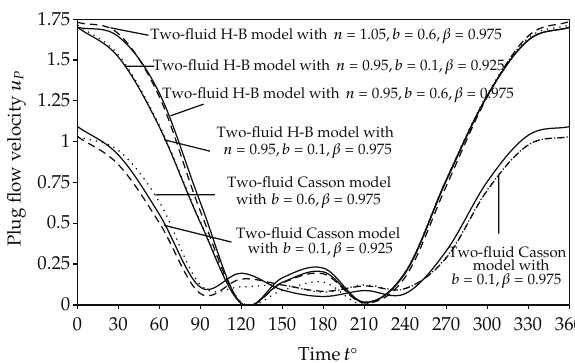
Figure 5: Variation of plug flow velocity in a time cycle for two-fluid H-B and Casson models and di ff erent values of n , b and β with t (cid:7) 60 ◦ , δ P (cid:7) θ (cid:7) 0 . 1, e (cid:7) 0 . 5, z (cid:7) 2 . 3, ω (cid:7) 1, φ (cid:7) α H (cid:7) α C (cid:7) 0 . 2, and ψ (cid:7) − 0 .